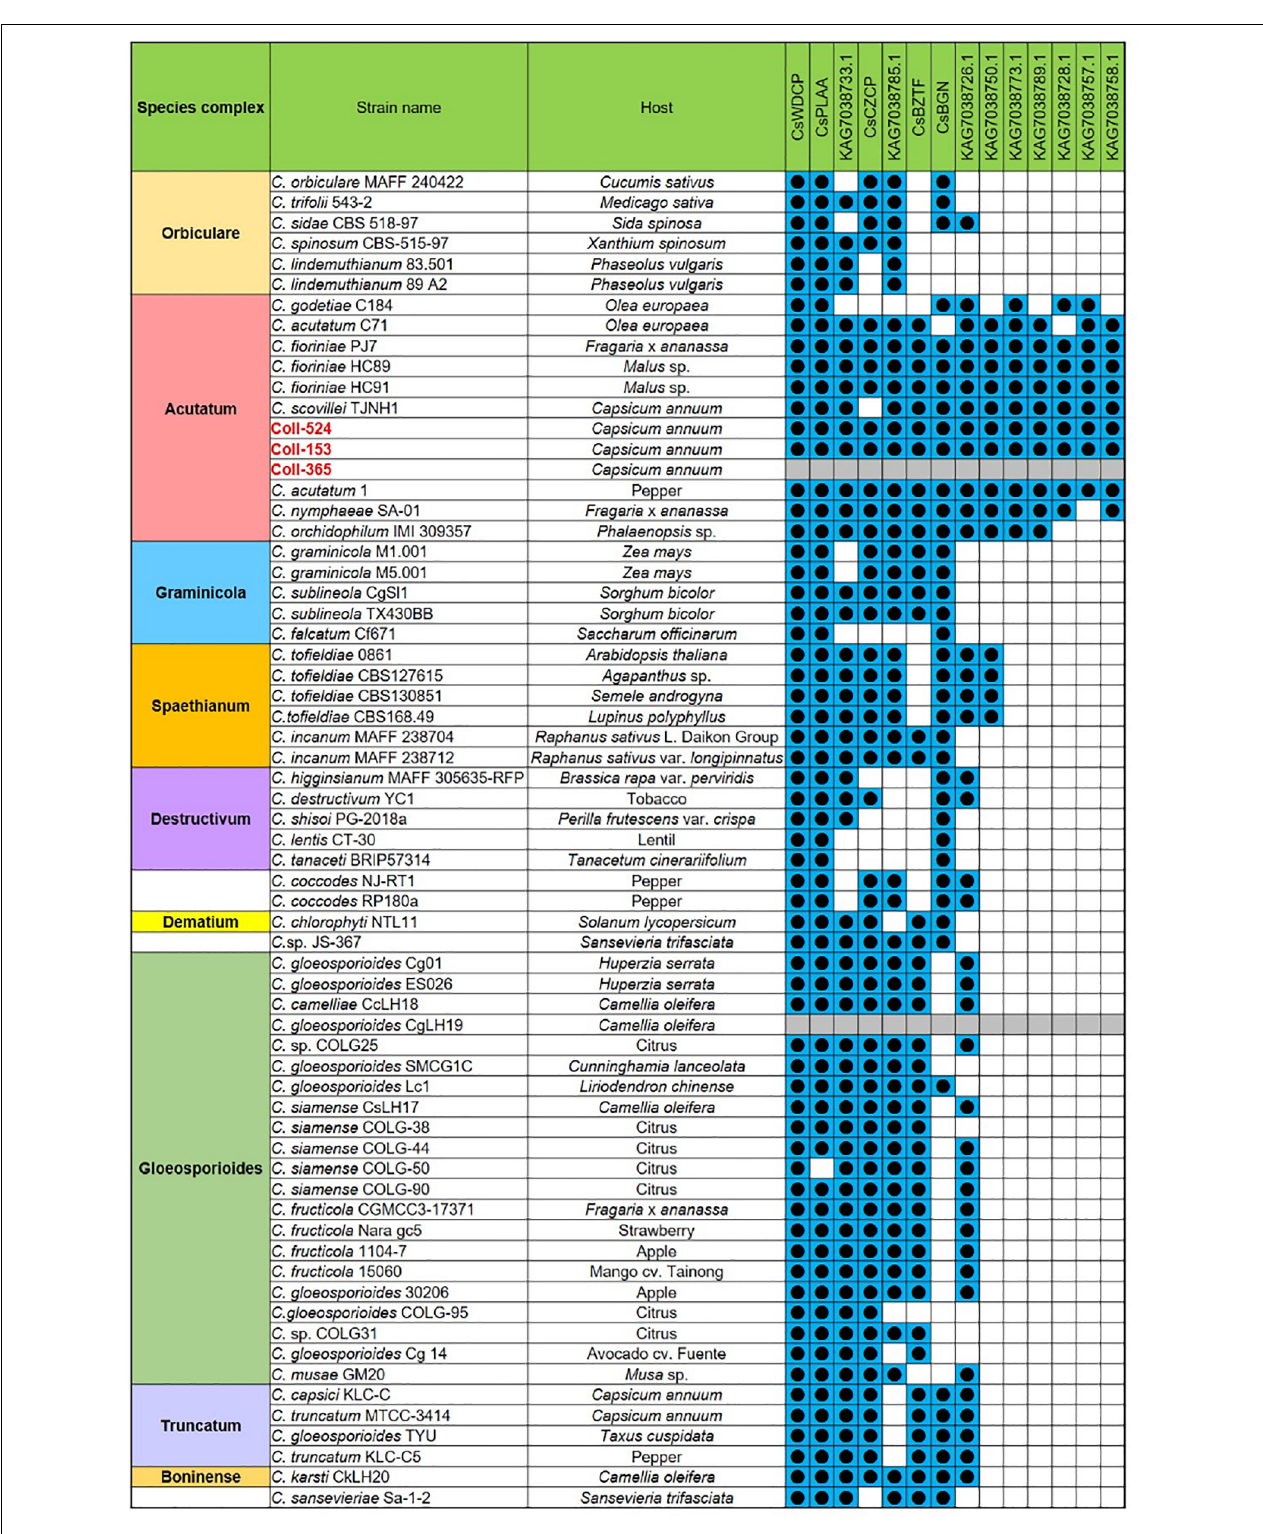
FIGURE 5 | The distribution of the 14 genes of scaffold 17 in strains Coll-524, 153, and 365, and the 62 Colletotrichum strains with whole genome sequences deposited in NCBI. The 14 genes were analyzed using nucleotide BLAST against the 62 genomes of Colletotrichum strains. Blue squares indicate the presence of genes by the blasting with coverage > 90% and identity > 60%. The gene was ordered from left to right by distribution frequency in the 62 genomes.